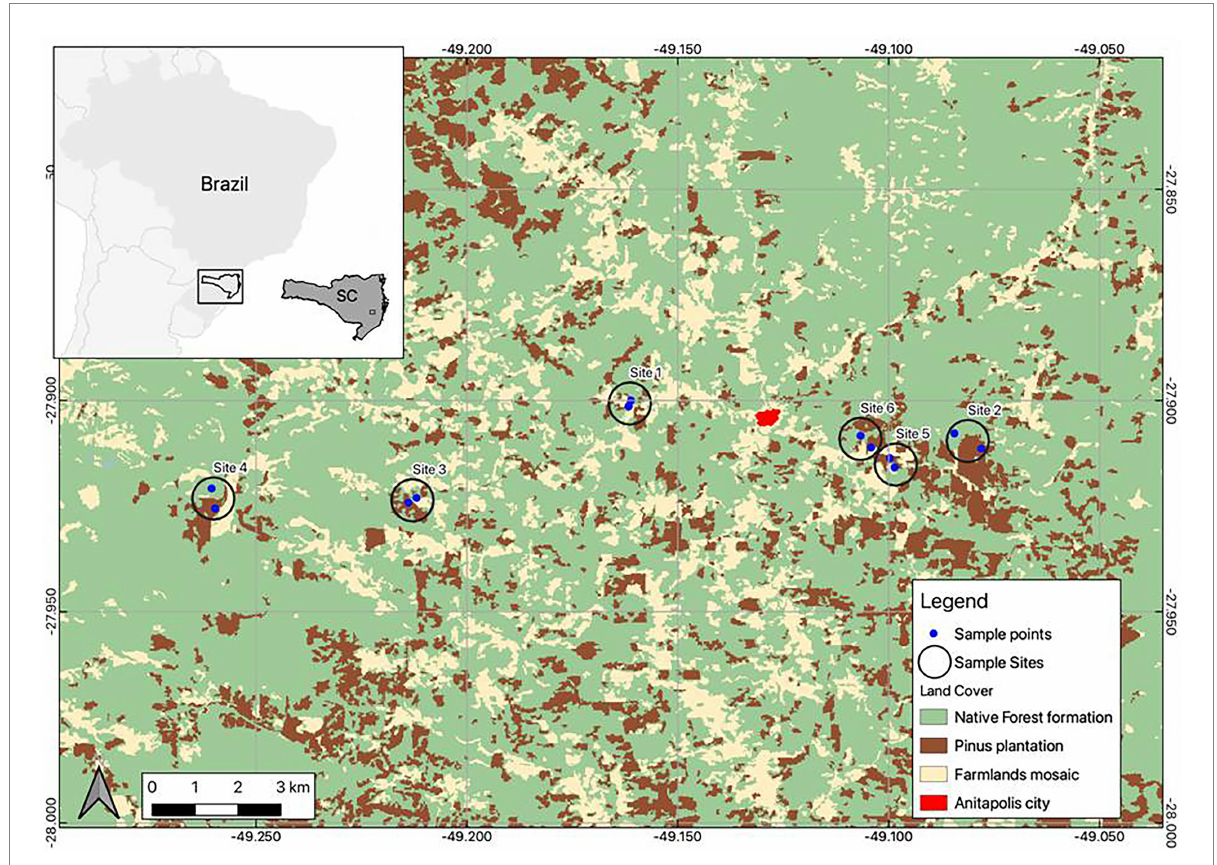
FIGURE 1 General view of the landscape and the six sample sites, each with two areas of different habitat (one of Pinus monocultures and one of native forest), in Santa Catarina, southern